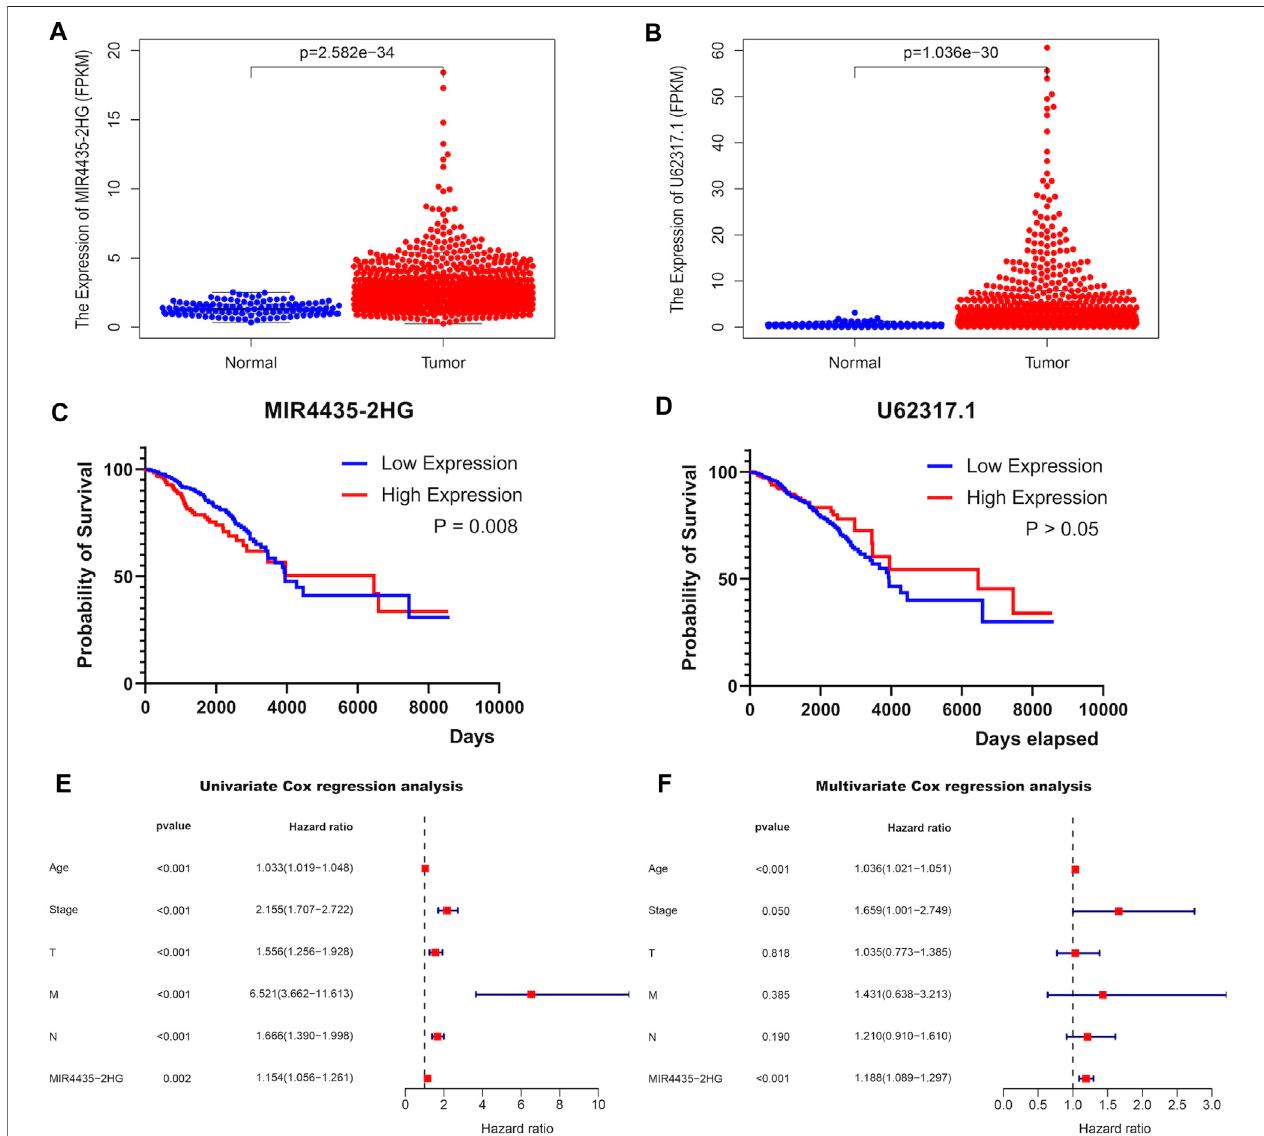
FIGURE 5 | Association of a single paired-DEirlncRNA with TCGA-BRCA. The expressions of lncRNA MIR4435-2HG (A) and lncRNA U62317.1 (B) between 113 normal and 1,109 tumor tissue samples in the TCGA-BRCA cohort. Kaplan-Meier survival curves of lncRNA MIR4435-2HG (C) and lncRNA U62317.1 (D) . Forest plots display that the univariate (E) and multivariate (F) cox regression analyses were performed the analysis of clinicopathological features with the expression of MIR4435-2HG.